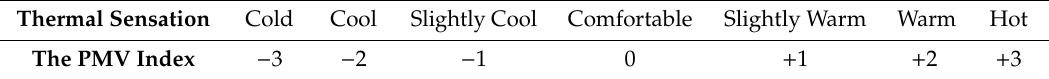
Table 1. Seven levels of the predicted mean vote (PMV) index corresponding to the seven thermal sensations. Thermal Sensation